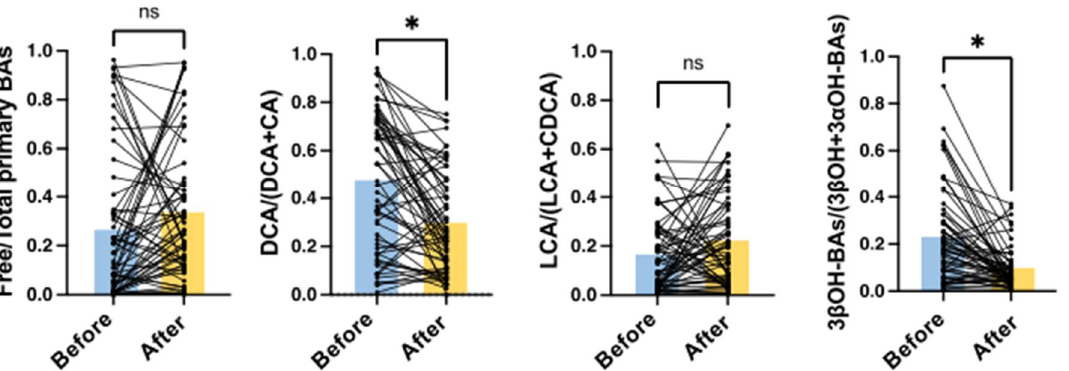
Figure 4. Effects of treatment with antibiotics on serum BA markers. Serum samples were obtained on admission (prior to antibiotic use and CDI onset) and after intravenous administration of antibiotics ( n = 61). Before, before using antibiotics; After, after using antibiotics. The mean value for each group is indicated by the columns. According to a paired t -test, * p < 0.0001 was significantly different; ns, not significant.